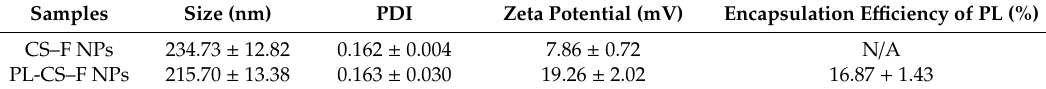
Table 1. Size, zeta potentials, polydispersity index (PDI), and piperlongumine (PL) encapsulation